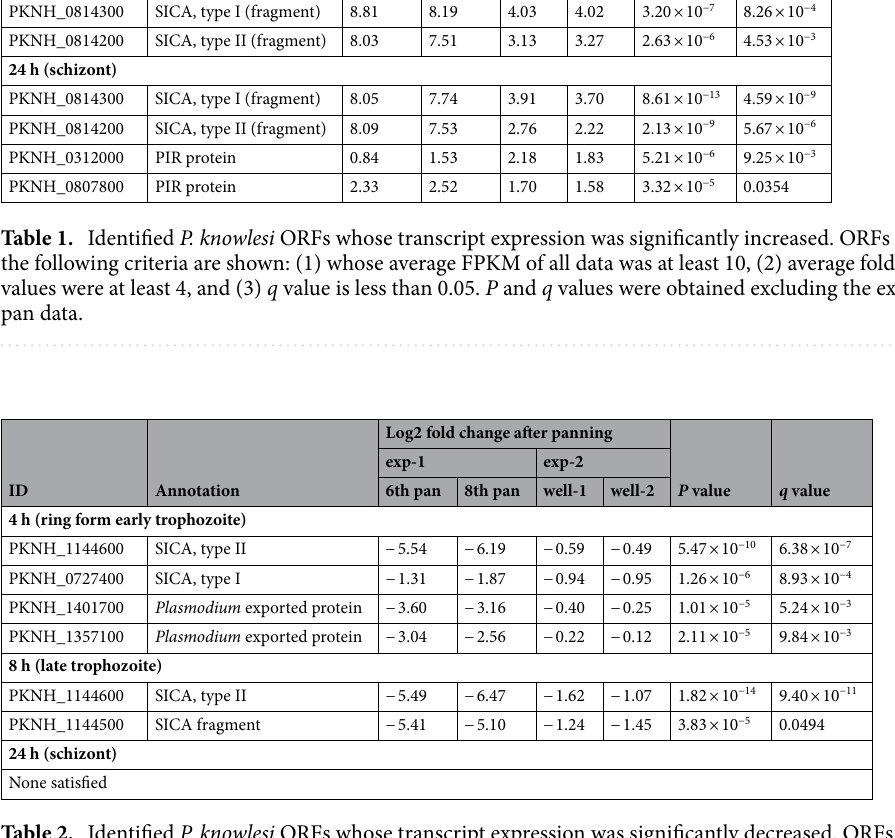
Table 2. Identified P. knowlesi ORFs whose transcript expression was significantly decreased. ORFs satisfying the following criteria are shown: (1) whose average FPKM of all data was at least 10, (2) average fold change values were less than or equal to 4, and (3) q value is less than 0.05. P and q values were obtained excluding the exp-1 6th pan data. PKNH_1144500 was annotated as “Protein conserved in P. knowlesi ” in PlasmoDB, but identified as a SICA fragment by BLASTP